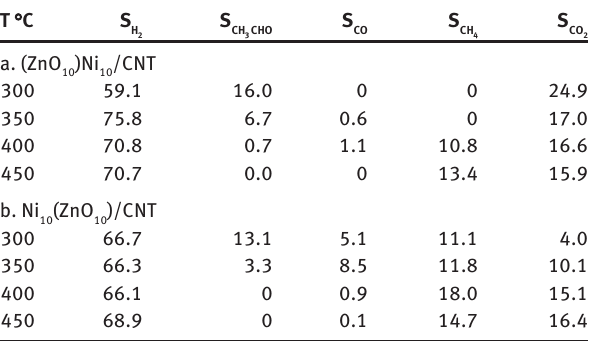
Table 4: The product selectivity over carbon nanotube (CNT)-based catalysts in steam reforming of ethanol (SRE) reaction as a function of